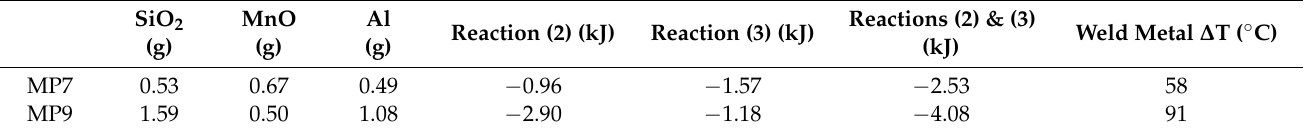
Table 6. Exothermic heat added to the weld pool from reactions (2) and